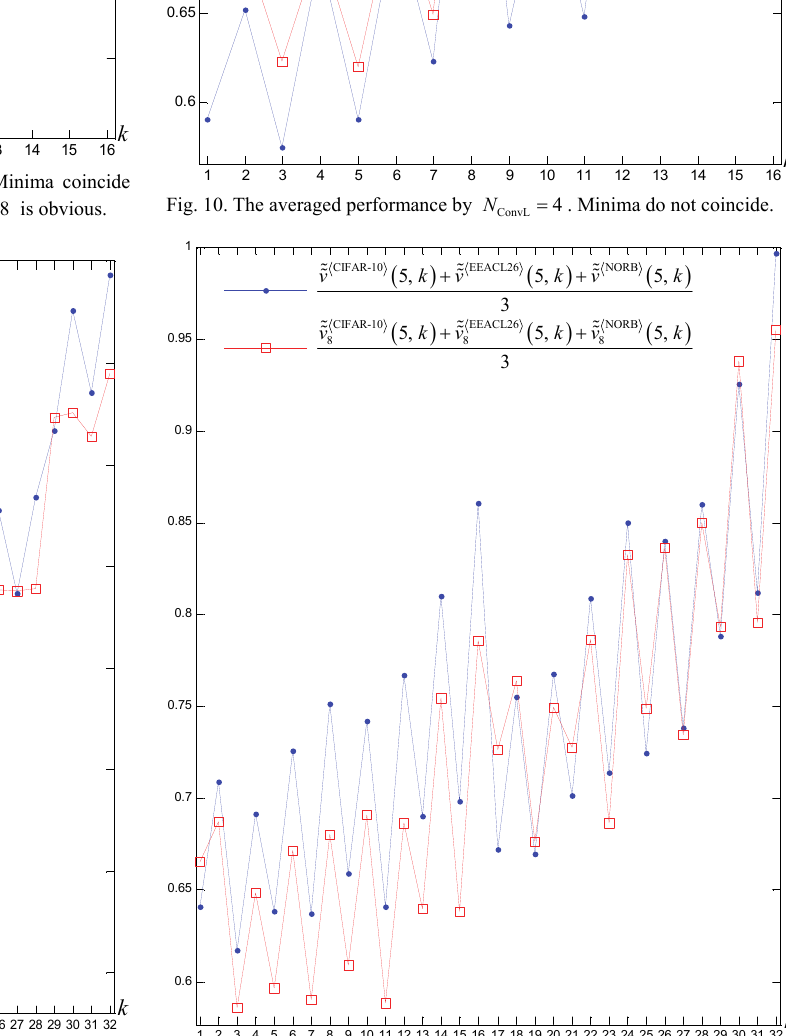
Fig. 9. Performance of CNNs with 5 ConvLs on NORB. Minima that 00010 and 01010 are statistically different, but very close. correspond to   2   2